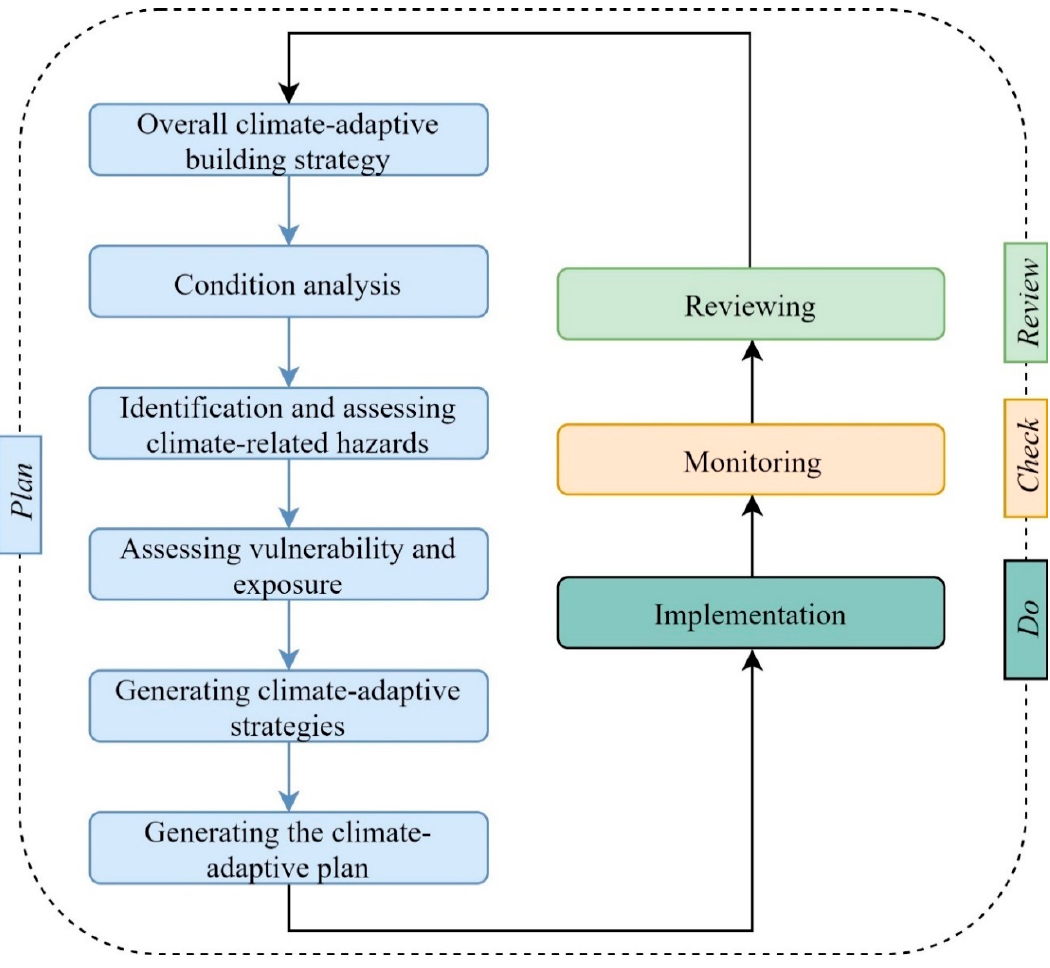
Figure 3. Proposed climate-adaptive maintenance and operation management (MOM) workflow.